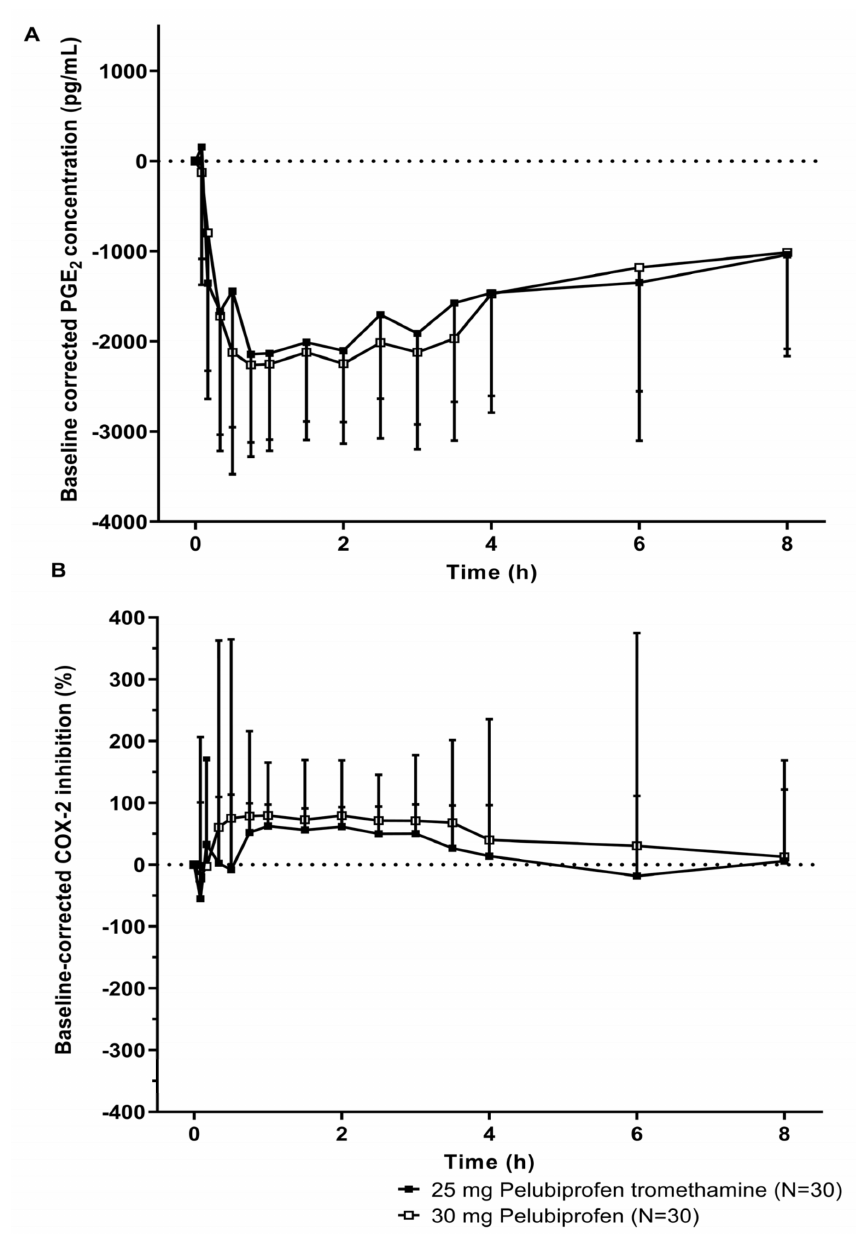
Figure 3. The extent of COX-2 inhibition determined from PGE 2 concentration from baseline levels after a single oral administration of 25 mg of pelubiprofen tromethamine or 30 mg of pelubiprofen in periods 1 and 2 of Study I are shown as the baseline-corrected PGE 2 concentration over time ( A ) and percent change from baseline COX-2 inhibition over time ( B ). The upper ( A ) and lower ( B ) panels are shown in linear scale as (mean − standard deviation) and (mean + standard deviation),